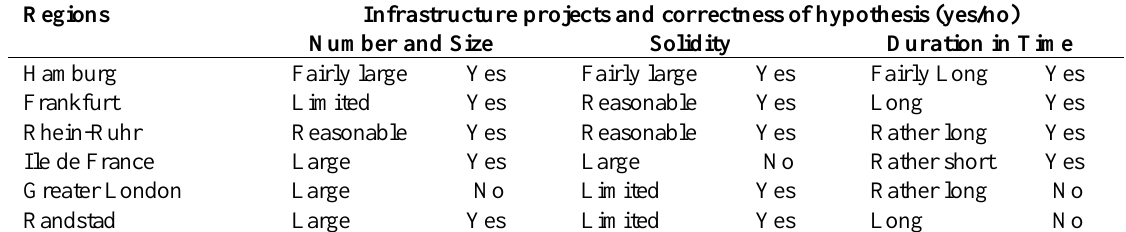
Table 5. Characteristics of infrastructure projects in various areas Regions Infrastructure projects and correctness of hypothesis